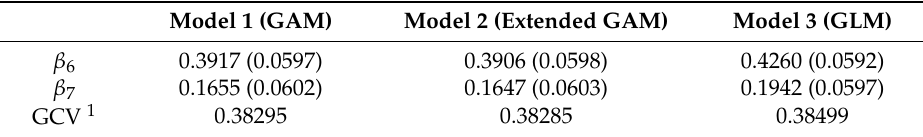
1 Generalized cross validation.